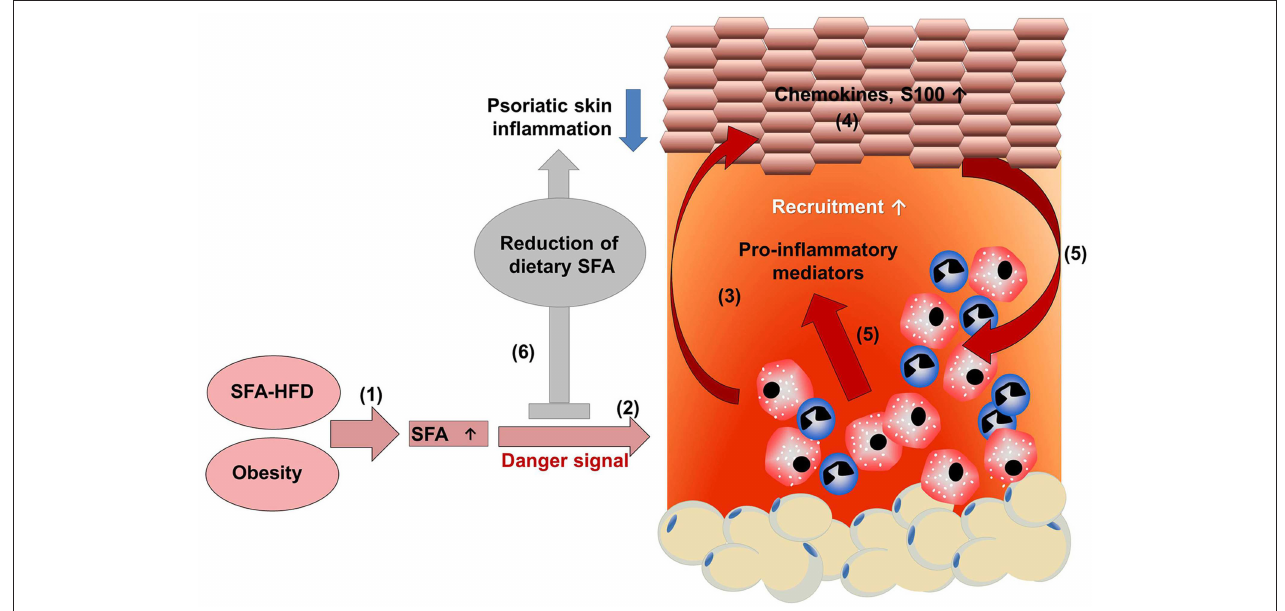
FIGURE 1 | HFD-derived SFAs amplify psoriatic inflammation. (1) A diet rich in saturated fatty acids (SFAs) increases SFA serum concentration. (2) Chronic intake of a high fat diet increases adipose tissue, resulting in obesity with high SFA serum levels. (2) SFAs sensitize myeloid cells resulting in an amplified pro-inflammatory response with enhanced secretion of pro-inflammatory mediators in the presence of a danger signal. (3) The enhanced myeloid cell activation contributes to a disturbance of keratinocyte proliferation, differentiation, and (4) enhances the production of chemokines and S100 proteins. (5) Consequently, more myeloid immune cells are recruited into skin lesion and activated, further enhancing psoriatic skin inflammation. (6) Dietary reduction of SFAs dampens psoriatic skin inflammation, which might support treatment efficacy in psoriatic patients.